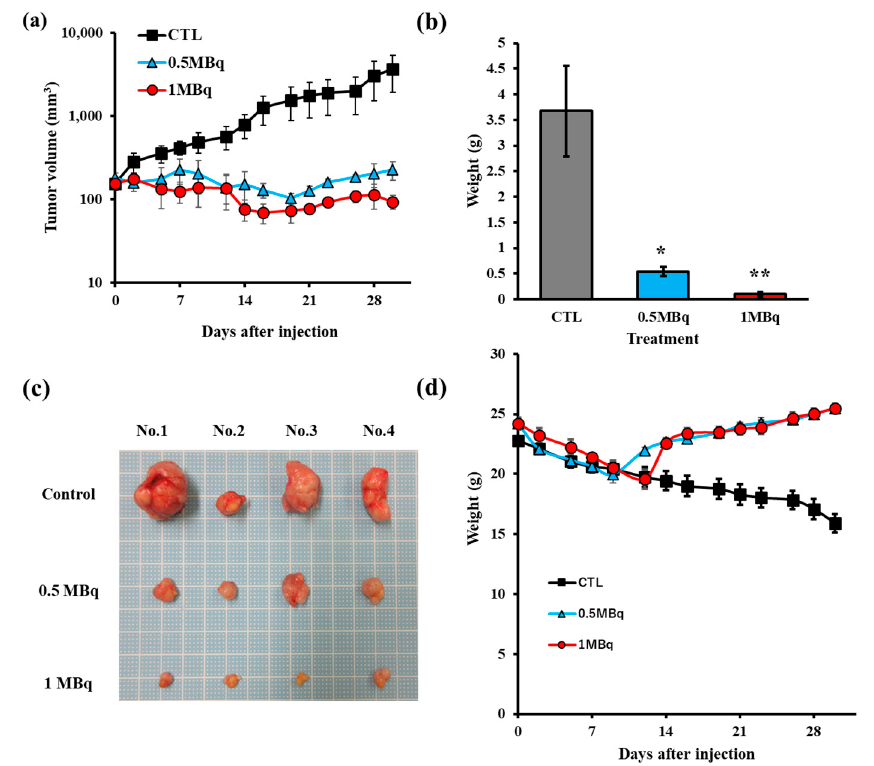
Figure 2. Tumor growth inhibition by 5 nm 211 At-AuNPs@mPEG in the PANC-1 xenograft model. At 2 weeks following tumor inoculation, 5 nm 211 At-AuNPs@mPEG (1 MBq or 0.5MBq/mouse) was injected, and 5 nm AuNPs@mPEG was injected to the control group (CTL). Tumor size ( a ) and weight ( d ) were measured thrice per week. Tumors were enucleated and weighed 30 days after injection ( b , c ). (* p < 0.05, ** p < 0.01).